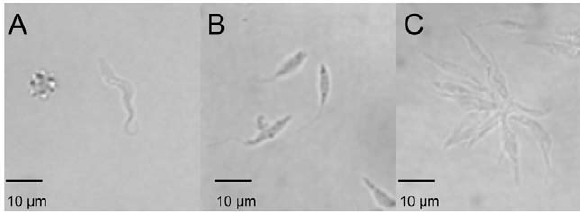
Figure 1. Establishment of axenic cultures of T.vivax epimas- tigotes. BSF (A), BSF-derived epimastigotes (B), Epimastigotes